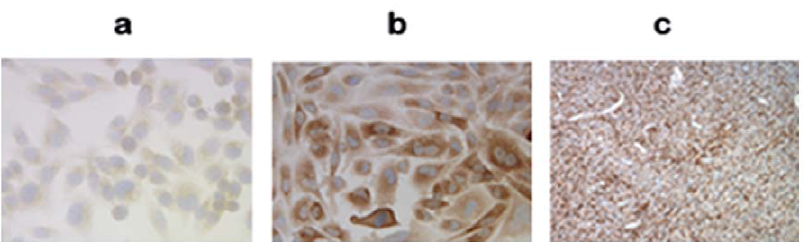
Figure 7. NPC2 protein expression in CHO cells. Immunohistochemical stain of NPC2 protein in wild CHO cell (a), CHO cells stably transfected with NPC2 (b) and xenograft of CHO cells transfected with NPC2 (c). No papilla was seen in the xenograft, despite abundant NPC2 protein